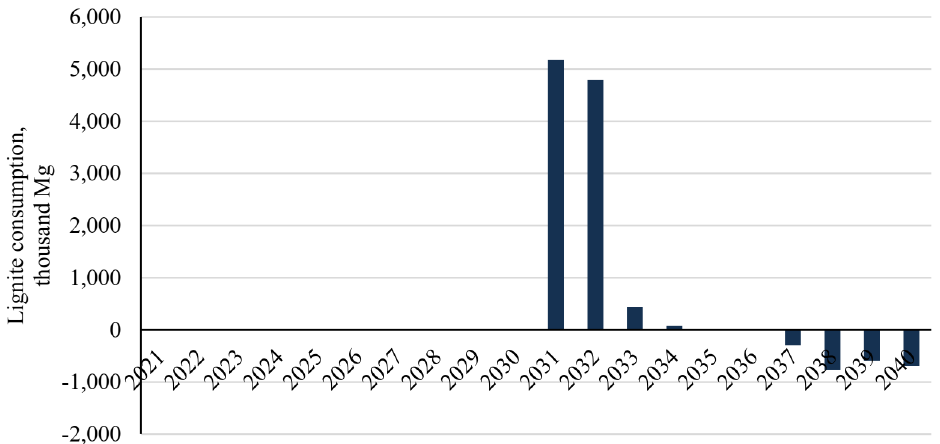
Figure 18. Differences in lignite consumption between the CM and EOM scenarios in